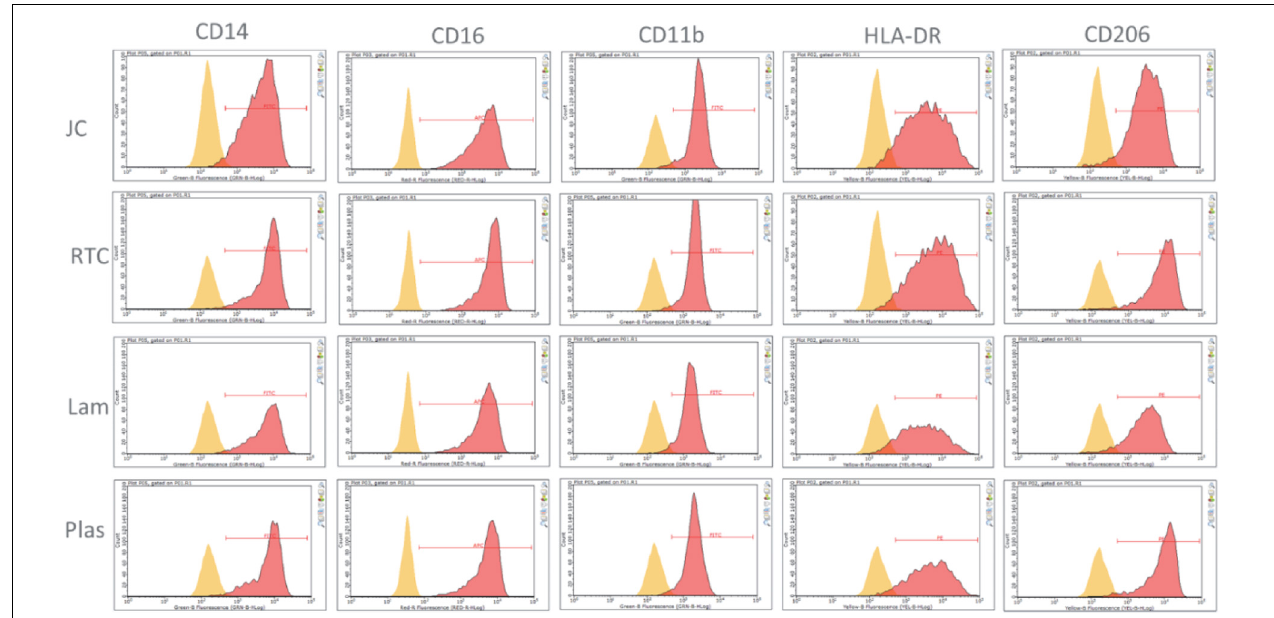
FIGURE 6 | Analysis of cell surface receptors using flow cytometry cultured on Jellyfish collagen (JC), rat tail collagen (RTC), laminin (Lam) and tissue culture plastic (Plas). Microglia cultured on 10 µ g/mL JC or RTC or controls for 48 h prior to staining. Yellow: Unstained control, Red: cell surface marker.